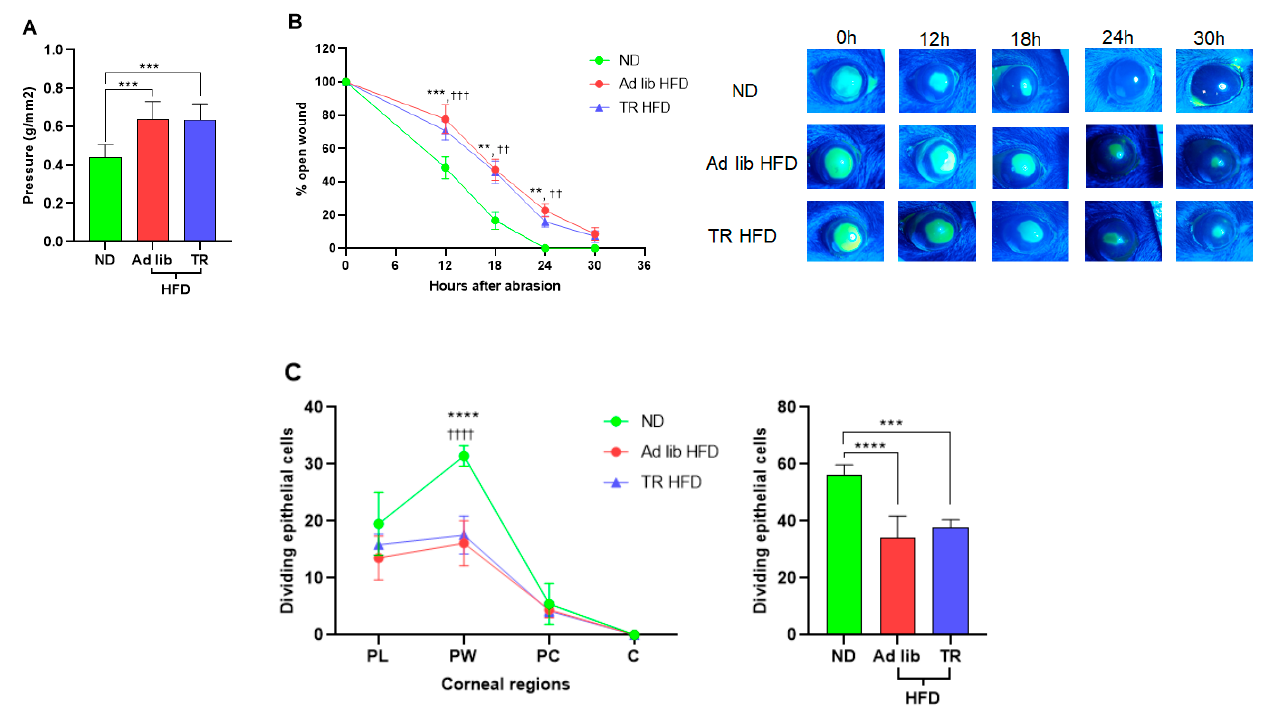
Figure 2. Time-restricted feeding did not attenuate reduced corneal sensitivity and impaired corneal wound healing. ( A ) Corneal sensitivity in 10 day ND fed mice compared to ad libitum and TR HFD fed mice ( n ≥ 6 per group). ( B ) Corneal wound closure in mice fed an ad libitum ND, an ad libitum HFD and a TR HFD. Left: Wound closure kinetics indicating complete wound closure by 24 h in ad libitum ND fed mice, while the wound remained open up to 30 h in the ad libitum HFD and TR HFD fed mice. Right: Representative images of the epithelial wound immediately after wounding, 12 h, 18 h, 24 h and 30 h after wounding. ( C ) Left: Dividing basal epithelial cells in each region of the cornea. Right: Sum of dividing basal epithelial cells in four fields of view from the paralimbus to the center of the cornea at 30 h after wounding ( n ≥ 6 per group). Data expressed as means ± SD. ** p ≤ 0.01, *** p ≤ 0.001, **** p ≤ 0.0001 (ad libitum HFD compared to ad libitum ND); †† p ≤ 0.01, ††† p ≤ 0.001, †††† p ≤ 0.0001 (TR HFD compared to ND).